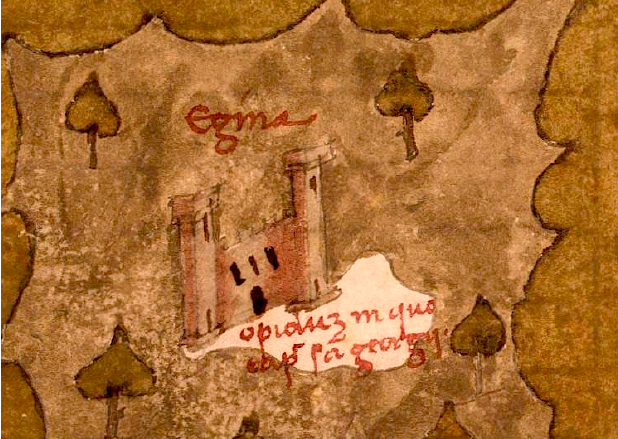
Figure 33. City of Paliachora with the cranium of St George. Christophoro Buondelmonti, Liber Insularum Archipelagi , X, 79. Paris, BN Ms. latin 4824, f. 52r (1465–1475). © Used with permission of Bibliothèque Nationale, Paris.